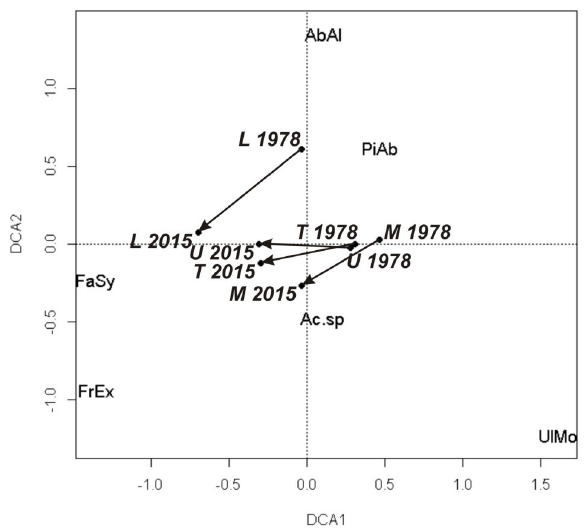
Figure 3. Long-term changes in tree species composition in NNR Dobročský prales between 1978 and 2015 in species ordination space ( DCA axes 1 and 2) according to tree layers (U–upper, M–middle, L–lower, T–total). Tree species acronyms: AbAl– Abies alba , PiAb– Picea abies , FaSy– Fagus sylvatica , FrEx– Fraxinus excelsior , UlMo– Ulmus montana , Ac.sp– Acer sp. Table 2. Density of seedlings and saplings (N · ha − 1 ) according to tree species and height/dbh category in particular development stages.